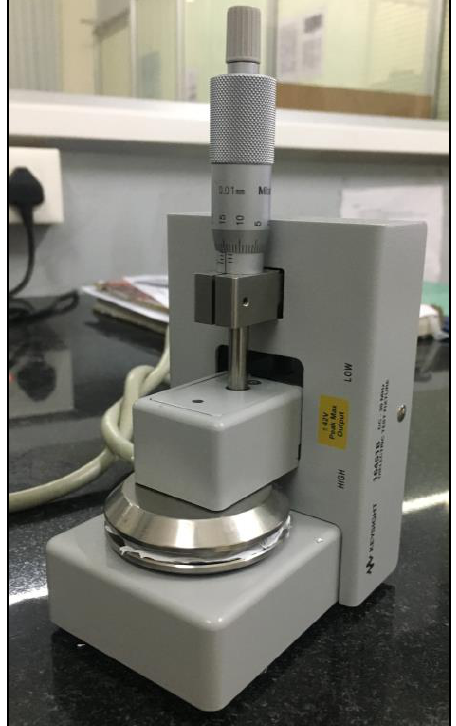
Figure 1. Probe measuring instrument (impedance analyzer) .